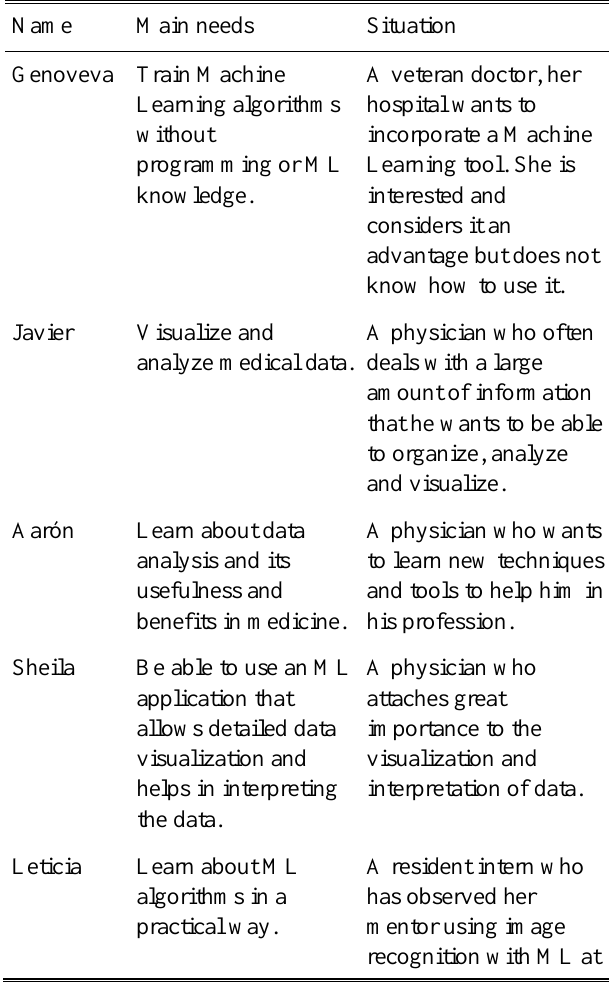
Table 1. User Persona definition